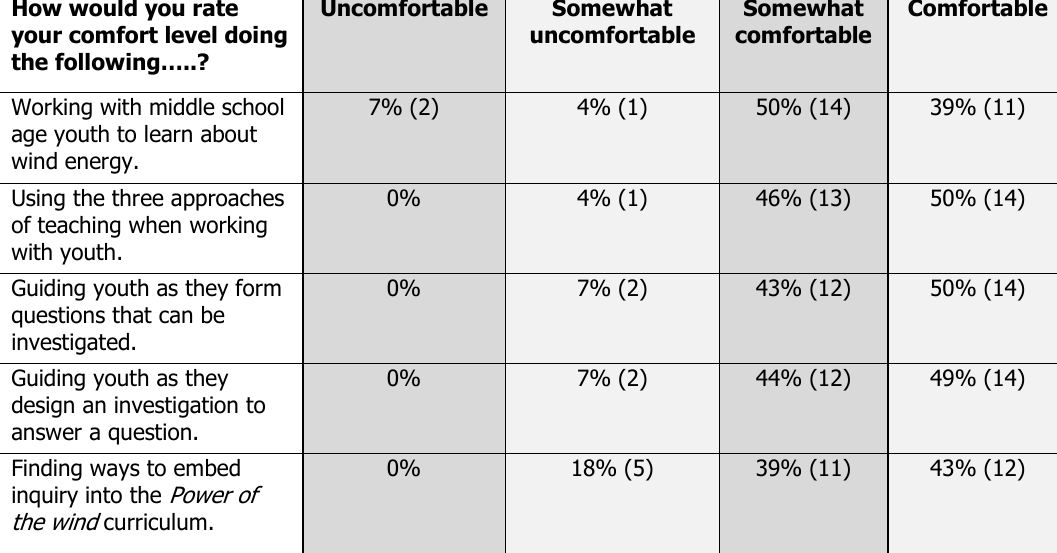
Adult Facilitators in Three Trainings Self-Assessments